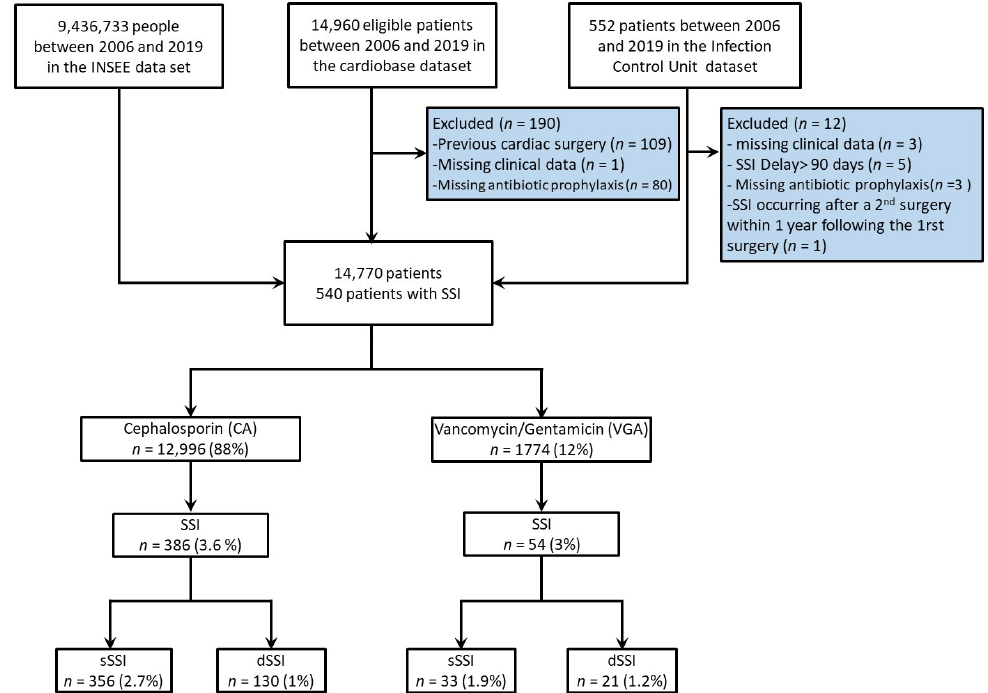
Figure 1. Flow chart of the study. INSEE: Institut National de la Statistique et des Etudes Economiques; SSI, surgical site infection. dSSI, deep SSI; sSSI: superficial SSI.